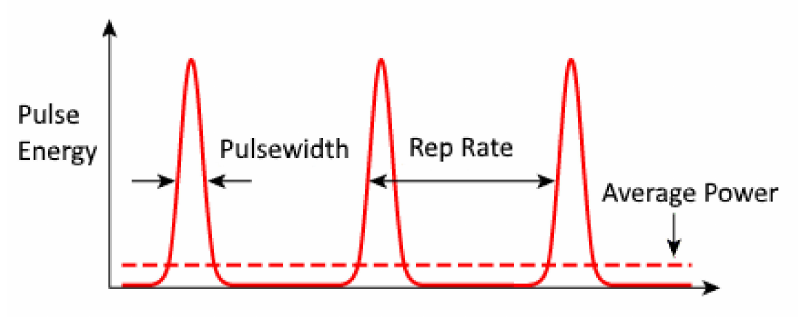
Figure 6. Representation of pulse width or